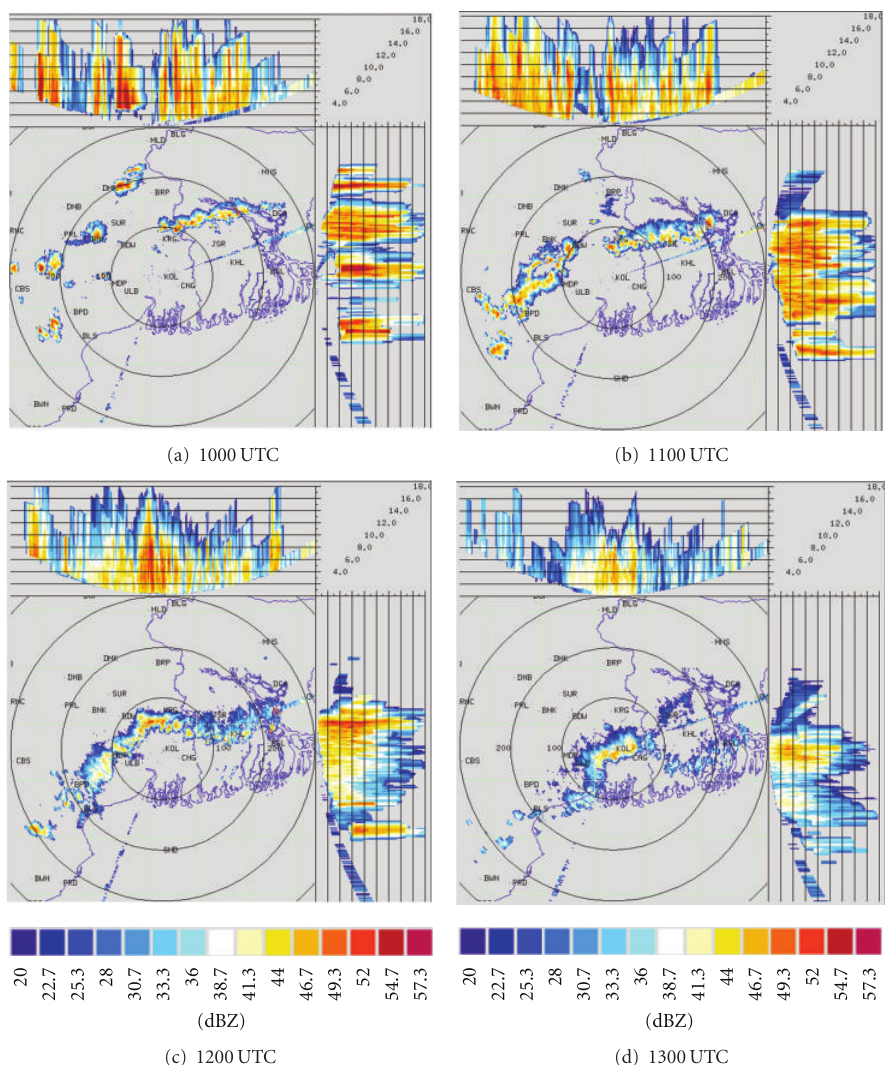
Figure 7: Kolkata DWR composite radar reflectivity (dBZ) imageries from 1000 to 1300 UTC on 11, May,